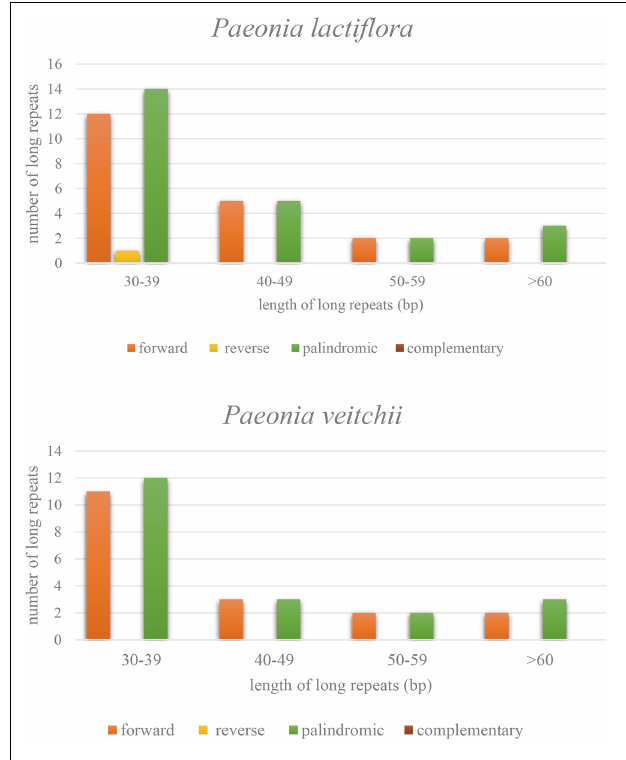
FIGURE 3 | Types and numbers of long repeat sequences in the chloroplast genomes of Paeonia lactiflora and Paeonia veitchii .